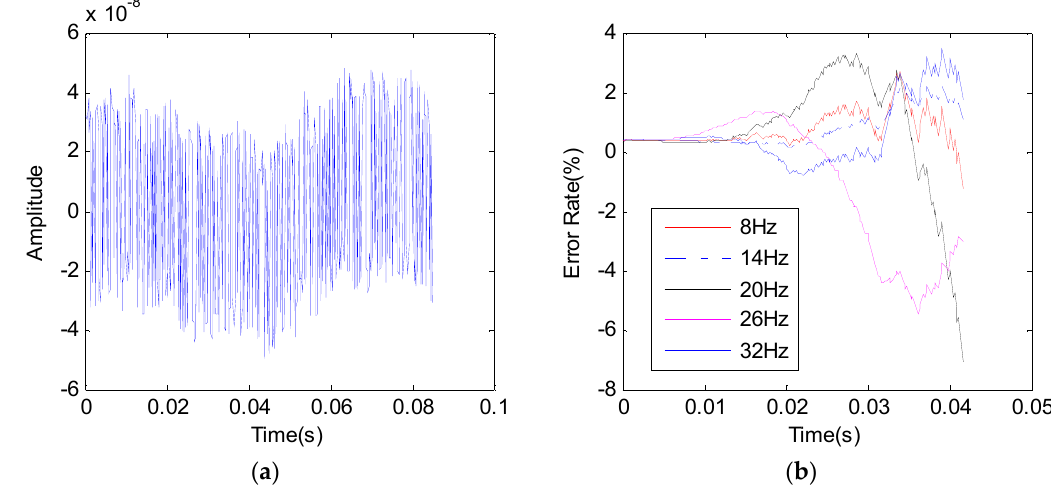
Figure 11. Suppression of Schumann frequency noise by m-sequence. ( a ) Superposition of excitation field and Schumann frequency noise signal; ( b ) identification error of different Schuhmann frequency noise.